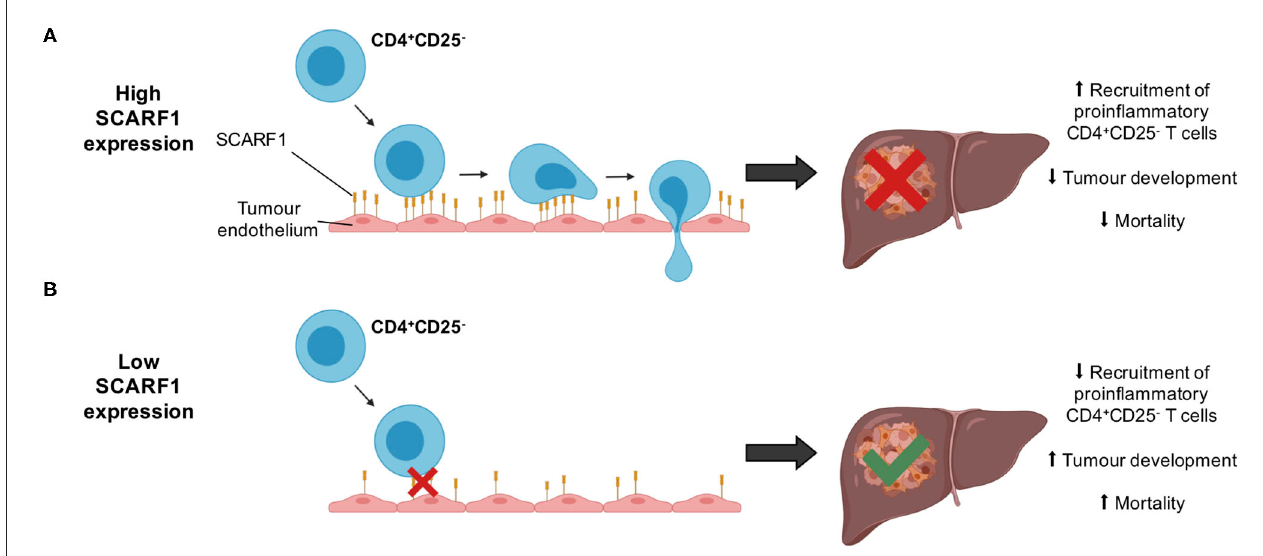
FIGURE 6 | Schematic representation of potential mechanism of action of SCARF1 in HCC tumors. (A) In the presence of high expression of SCARF1 in tumor endothelial cells, proinflammatory CD4 + CD25 − T cells are recruited to HCC tumors, resulting in decreased tumor development and, ultimately, decreased mortality. (B) In low expression of SCARF1 in tumor endothelial cells, recruitment of CD4 + CD25 − T cells lower, resulting in increased tumor development and mortality. Image created with